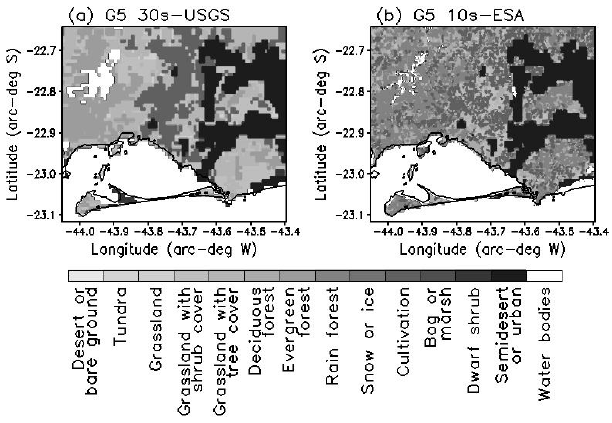
Figure 5. Vegetation-type shaded maps for G5, processed with (a) 30arc-sec USGS and (b) 10arc-sec ESA databases.